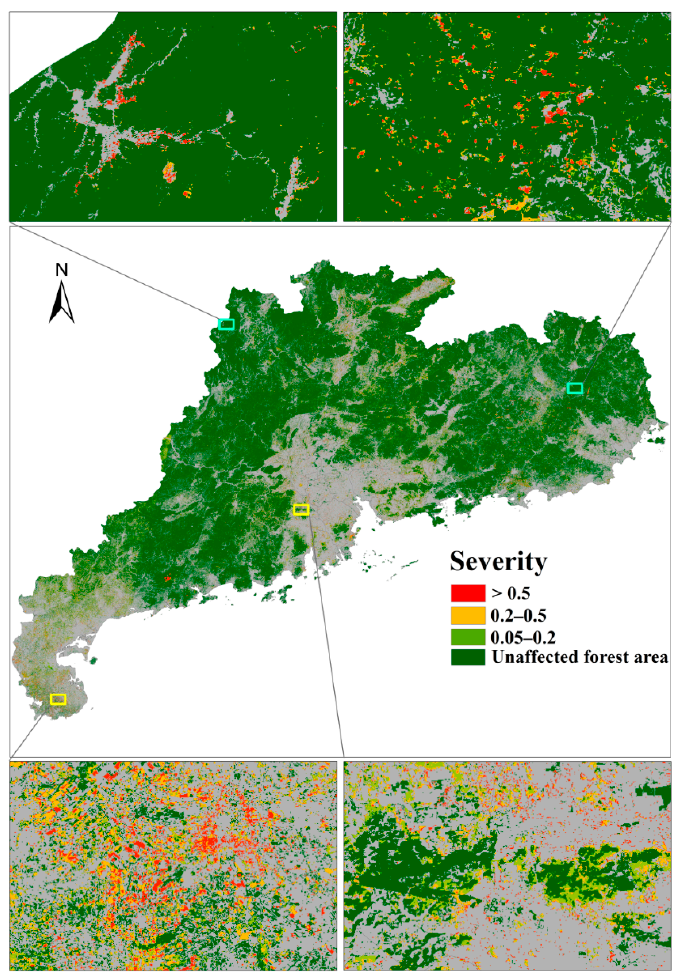
Figure 7. The spatial distribution of affected forest area and damage severity (0–1) caused by Typhoon Rammasun in Guangdong Province. Table 4. The affected forest area and proportions of different damage severities in cities or counties of Guangdong Province.